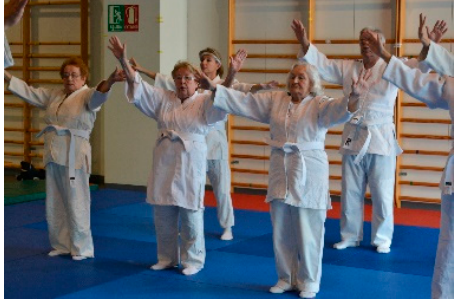
Figure 7. Polish the mirror.